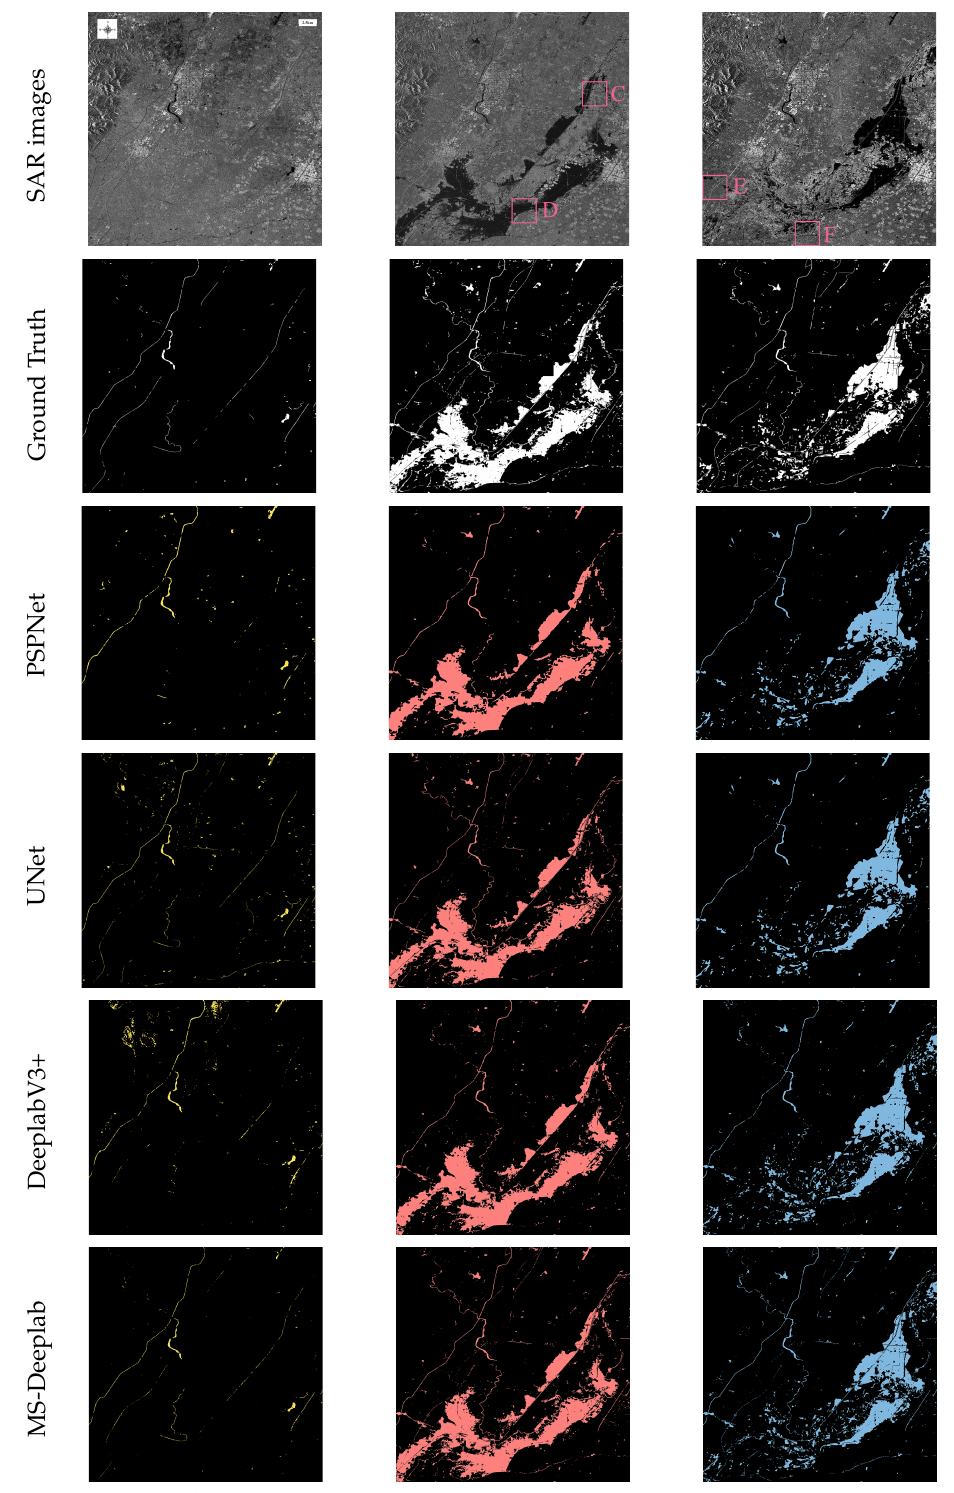
Figure 10. Time series of SAR images and segmentation results of the area near Xinxiang City. The first row is the time series of SAR images. The second row is the ground truth. The third row is the segmentation results generated by PSPNet. The fourth row is the segmentation results generated by UNet. The fifth row is the segmentation results generated by DeeplabV3+. The sixth row is the segmentation results generated by the proposed MS-Deeplab